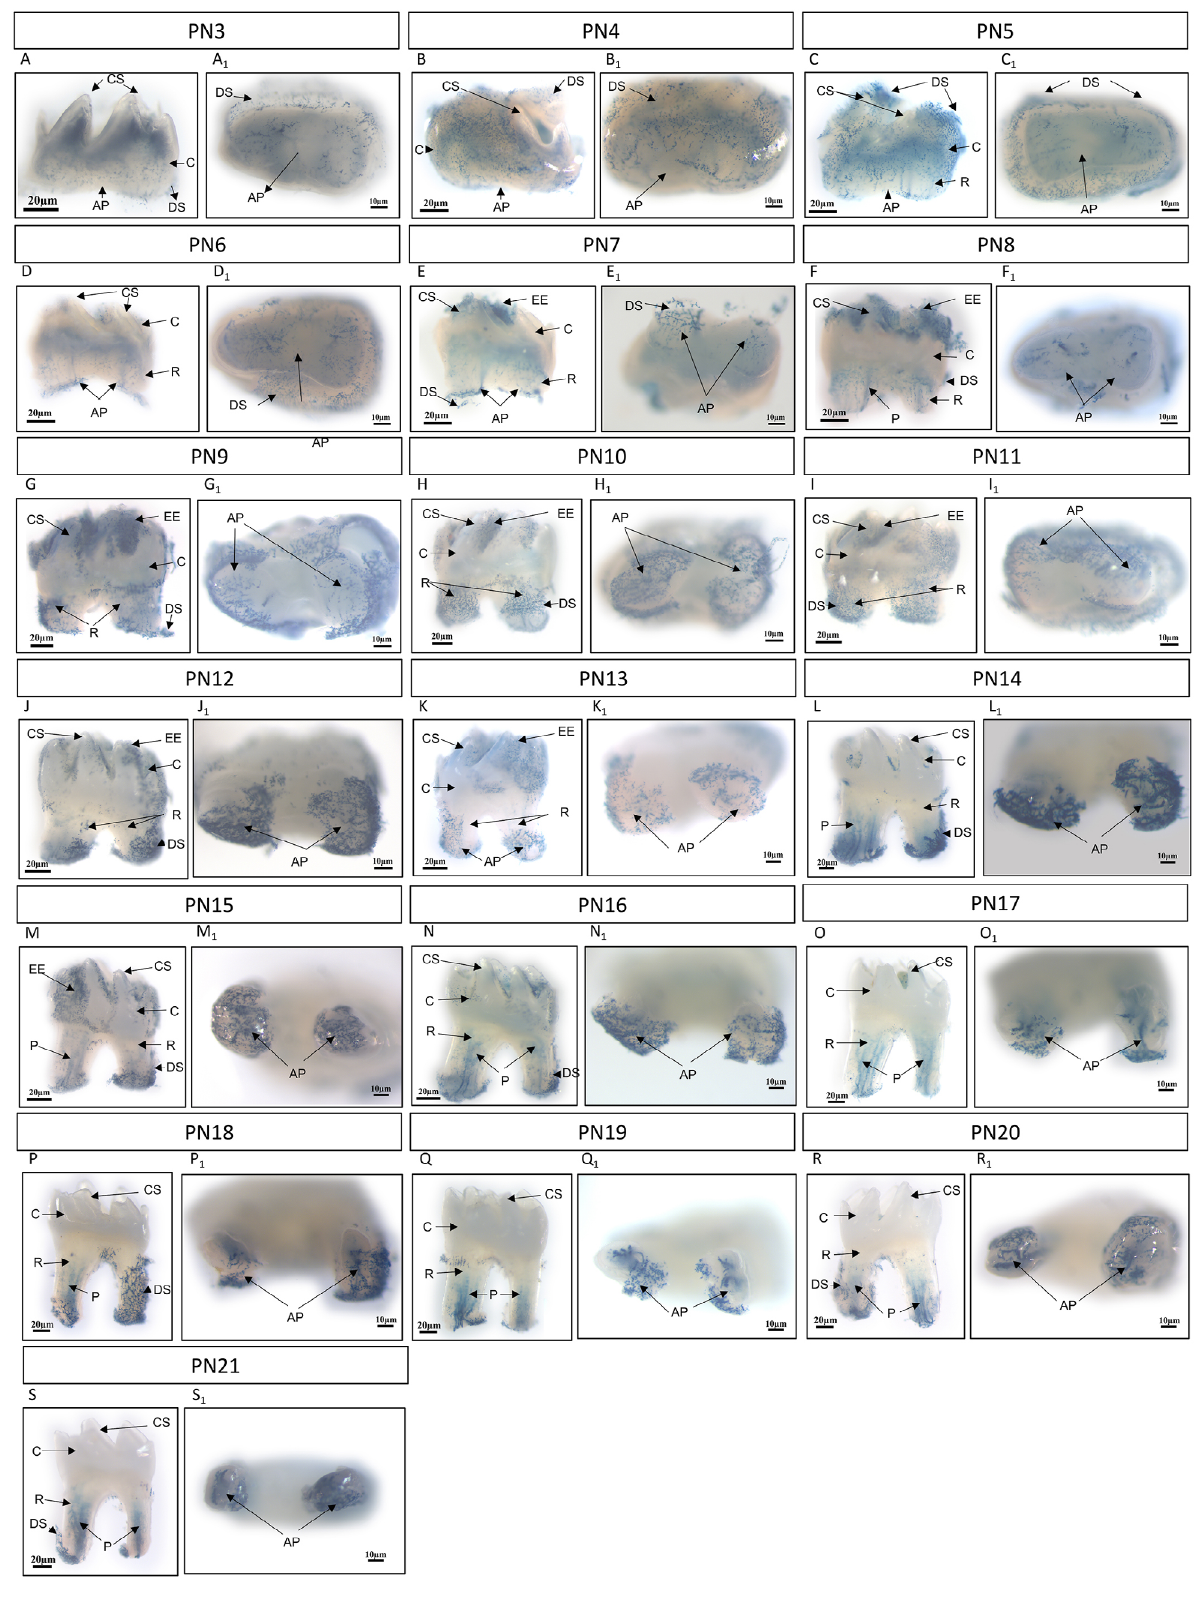
Figure 1- BRE-LacZ reporter activity during M1 postnatal development in mice ranging from postnatal day (PN) 3 to PN21. A whole- mount X-gal staining of M1 showed BRE-dependent BMP signaling in the buccal/lingual view (A, B, C, D, E, F, G, H, I, J, K, L, M, N, O, P, Q, R, and C) and in the apical view (A1, B1, C1, D1, E1, F1, G1, H1, I1, J1, K1, L1, M1, N1, O1, P1, Q1, R1, and S1). On PN3-PN5, active BMP/Smad signaling was identified in the coronal pulp and dental sac surrounding M1 (A–C) (A1–C1). On PN6–PN8, active BMP/ Smad signaling could be observed in the dental papilla and root sheath (D–F) (D1–F1). On PN9–PN14, strong BMP/Smad signaling was observed in the root-forming regions, more specifically in the apical papilla and root sheath (G–L) (G1–L1). On PN15–PN21, the expression of BMP/Smad signaling was diminished around the root but existed in the apical region and along the ordered lining of blood vessels in the pulp (M–S) (M1–S1). (EE, enamel epithelium; DS, dental sac; CS, cusp; C, crown; R, root; AP, apical papilla; P,